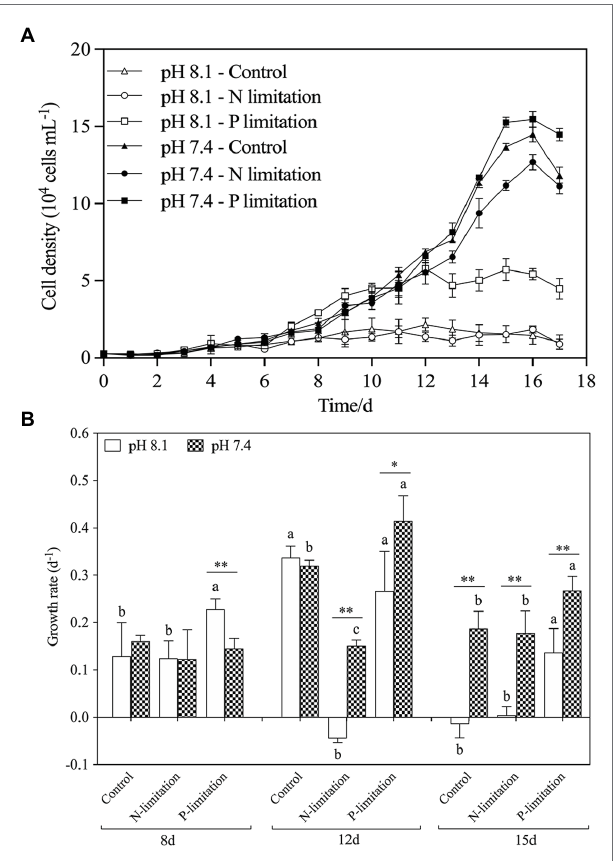
FIGURE 4 | The changes of population dynamics of K. mikimotoi under seawater acidification conditions when exposed to different nutrient levels. Data are presented as means ± SD. (A) Cell density; (B) Specific growth rate. Different lowercase letters indicate significant differences among the three nutrient levels within each pH treatment at each time point ( p < 0.05). Asterisks indicate significant differences between two pH levels within each nutrient treatment ( p < 0.05).